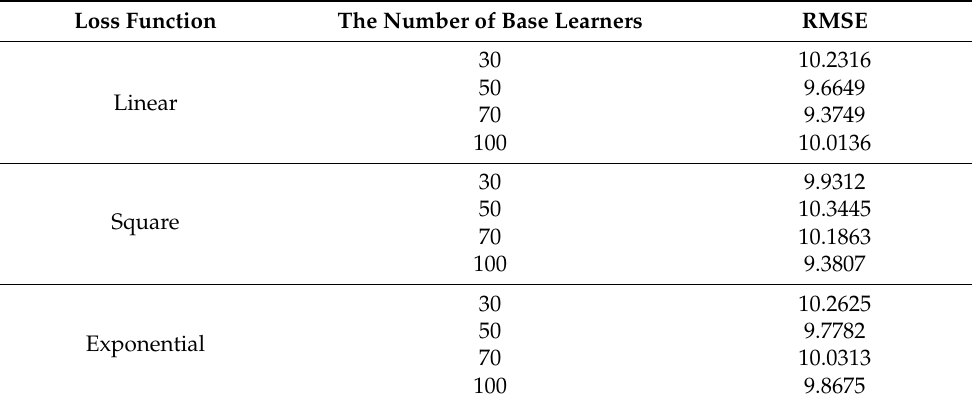
Table 6. The results of ensemble learning module with different